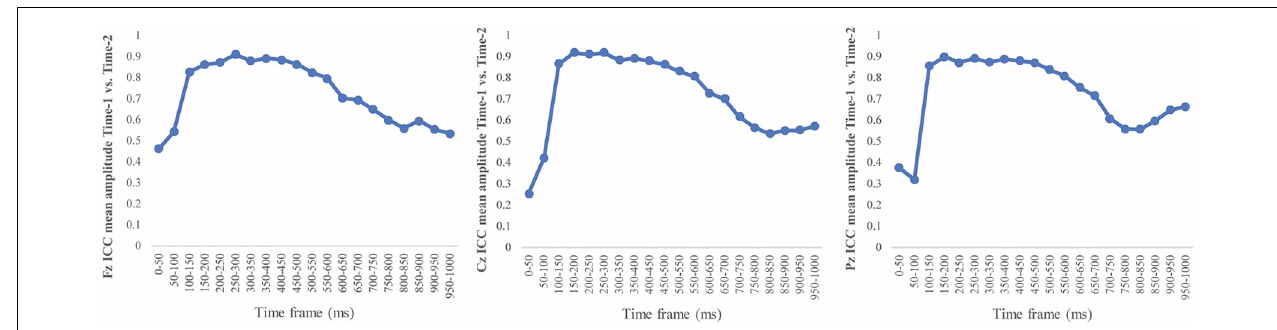
FIGURE 6 | Intraclass correlation coefficient (ICC) between Time-1 and Time-2 of the mean amplitude for each 50 ms post novel stimuli at Fz, Cz, and Pz.